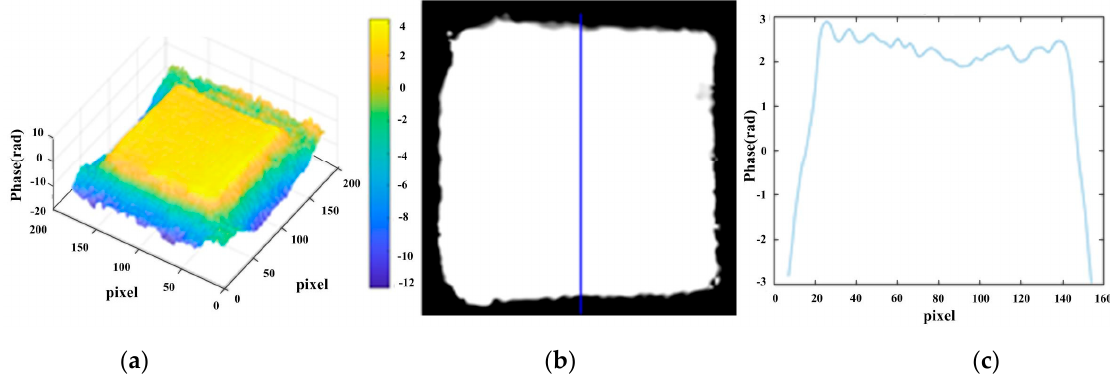
Figure 9. Reconstructed phase of step. ( a ) 3D profile; ( b ) Extracting phase along the central line; ( c ) 2D profile.